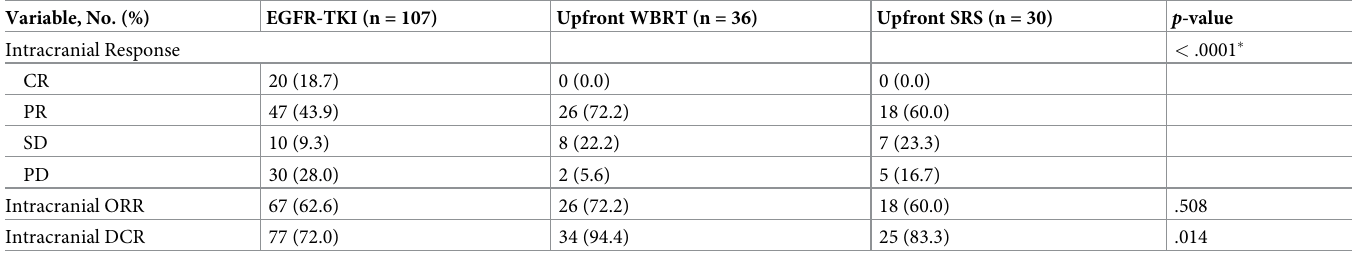
Table 2. Comparison of the response among the three groups at 1st evaluation after treatment. Variable, No.